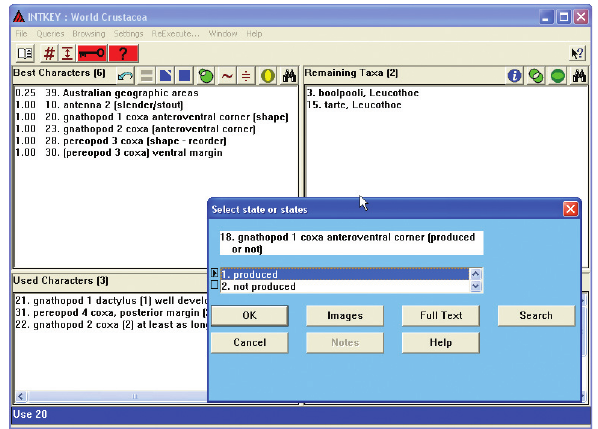
Figure 78. Character 20 is connected to character 18. Clicking on character 20 will open character 18 fi rst.